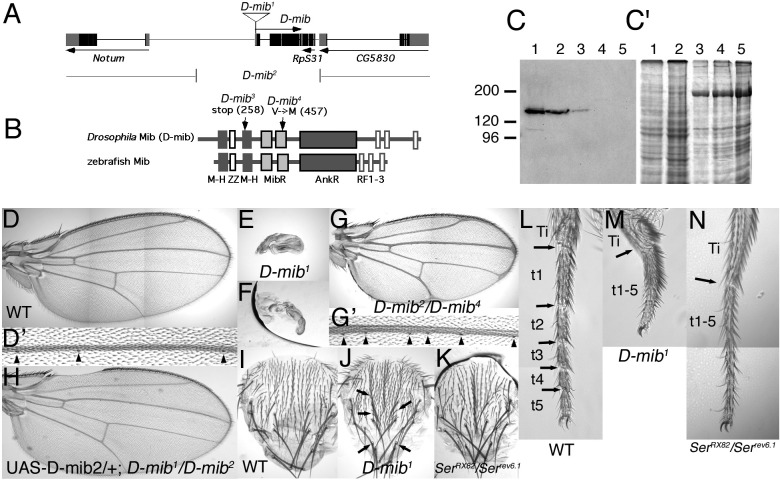
Molecular and Genetic Characterization of D-mib Mutations(A) Molecular map of the D-mib locus showing the position of the P-element inserted into the 5′ untranslated region (allele D-mib1) and the 13.6 kb deletion that removes the D-mib and the RpS31 genes (allele D-mib2). Transcribed regions are indicated with arrows, and exons are indicated with boxes. Open reading frames are shown in black.(B) Domain composition of D-mib and D. rerio Mib. Both proteins show identical domain organization. D-mib has an N-terminal ZZ zinc finger flanked on either side by a Mib/HERC2 (M-H) domain, followed by two Mib repeats, six ankyrin repeats, two atypical RING domains, and a C-terminal protypical RING that has been associated with catalytic E3 ubiquitin ligase activity. The D-mib3 mutant allele is predicted to produce a truncated protein devoid of E3 ubiquitin ligase activity whereas the D-mib4 protein carries a mutation at a conserved position in the second Mib repeat.(C and C′) Western blot analysis of D-mib (C). The endogenous D-mib protein (predicted size: 130 kDa) was detected in S2 cells (lane 2) and in imaginal discs from wild-type larvae (lane 3) but was not detectable in homozygous D-mib1 (lane 4) and D-mib1/D-mib3 (lane 5) third instar larvae. The D-mib protein produced in transfected S2 cells from the cDNA used in this study (lane 1) runs exactly as endogenous D-mib (lane 2). Panel C′ shows a Red Ponceau staining of the gel with the same protein samples as in panel C.(D–H) Wings from wild-type (D), D-mib1 (E), SerRX82/Serrev6.1 (F), D-mib2/D-mib4 (G), and UAS-D-mib2/+; D-mib1/D-mib2 flies (H). D-mib (E) and Ser (F) mutant flies showed similar wing loss phenotypes. The D-mib mutant phenotype could be almost fully rescued by a leaky UAS-D-mib transgene (H). (D′) and (G′) show high magnification views of (D) and (G), respectively, to show that D-mib2/D-mib4 mutant flies (G′) exhibited ectopic sensilla (arrowheads) along vein L3.(I–N) Nota (I–K) and legs (L–N) from wild-type (I and L), D-mib1 (J and M), and SerRX82/Serrev6.1 (K and N) flies. D-mib mutant flies showed a weak neurogenic phenotype (J) that was not observed in Ser mutant flies (K). Ectopic sensory organs in D-mib mutant flies developed from ectopic sensory organ precursor cells (not shown). D-mib (M) and Ser (N) mutant legs also showed distinct growth and/or elongation defects. Arrows in (J) show ectopic macrochaetes. Arrows in (L–N) indicate the joints. Ti, tibia; t1 to t5, tarsal segments 1 to 5.